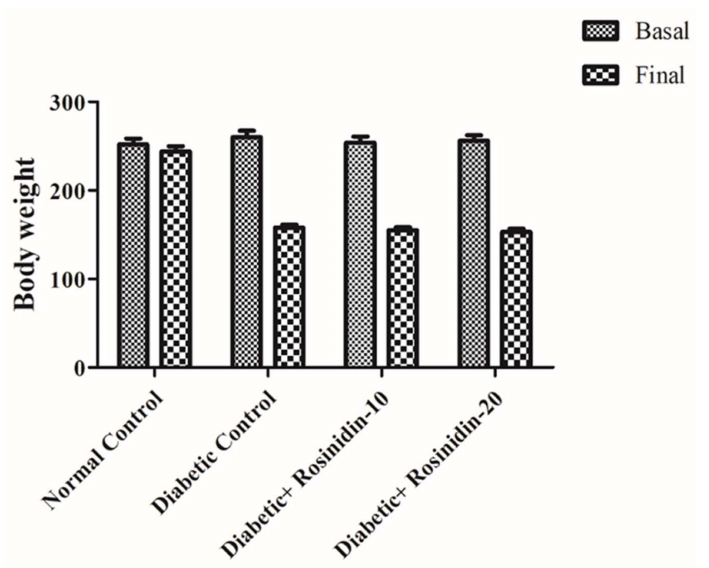
Figure 1. Effect of rosinidin treatments on body weights against those of STZ-induced diabetic rats ( n = 6).